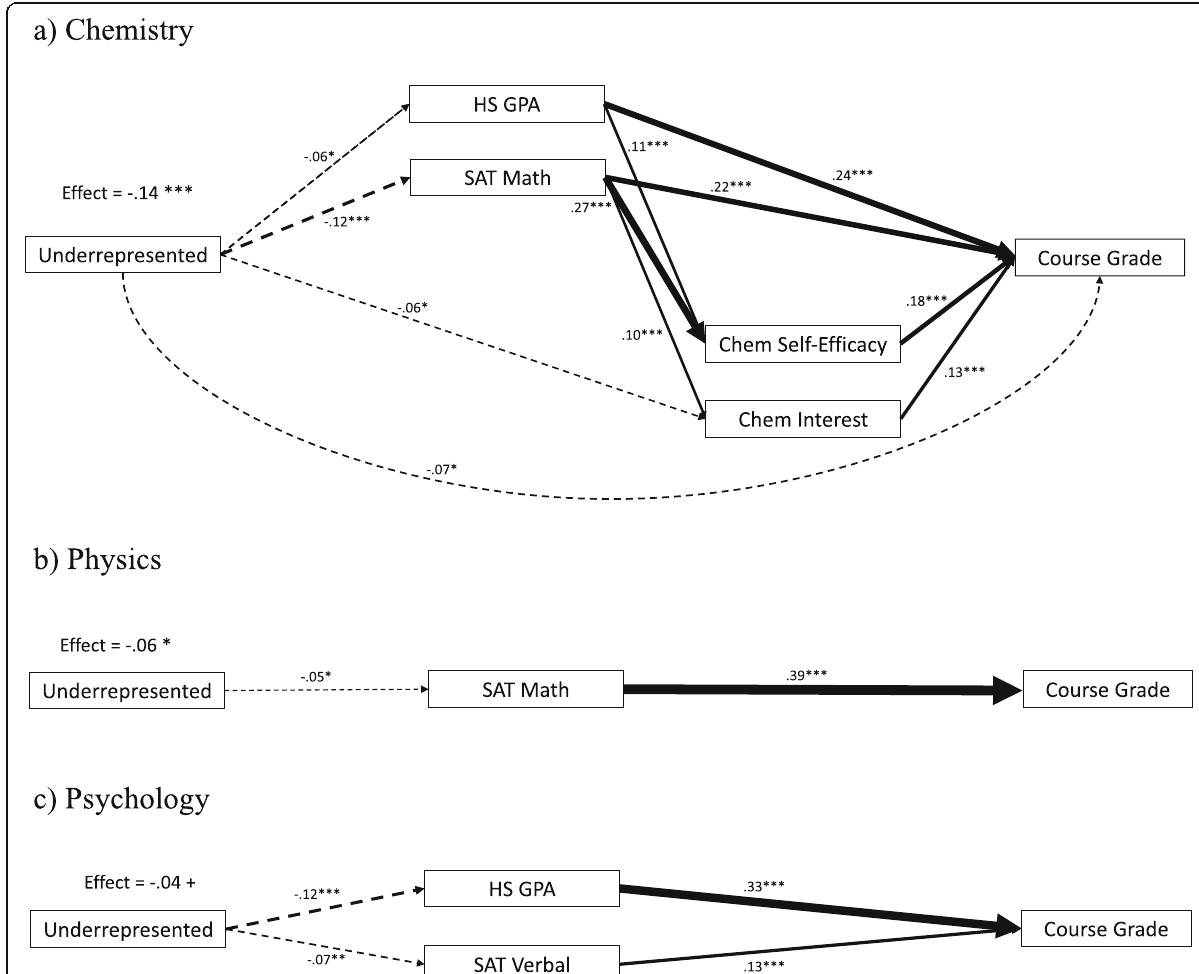
Fig. 3 Significant direct effects between students ’ race/ethnicity, academic resources, discipline-specific attitudes, and introductory course grades. Note: Solid arrows indicate significant direct effects, dashed arrows indicate significant negative direct effects, and line thickness denotes the size of the standardized path coefficient. These figures only display pathways with significant indirect effects relevant to course grade outcomes; see Fig. 5 for all significant pathways. The final models for each course provided good fits to the data: chemistry RMSEA < .01 (90% CI .00, .03), CFI > .99, and TLI > .99; physics RMSEA = 0.01 (90% CI 0.00, 0.03), CFI > .99, and TLI > .99, and psychology RMSEA = 0.02 (90% CI 0.00, 0.03), CFI > .99, and TLI = .99. *** p < .001. ** p < .01. * p < .05. +p <